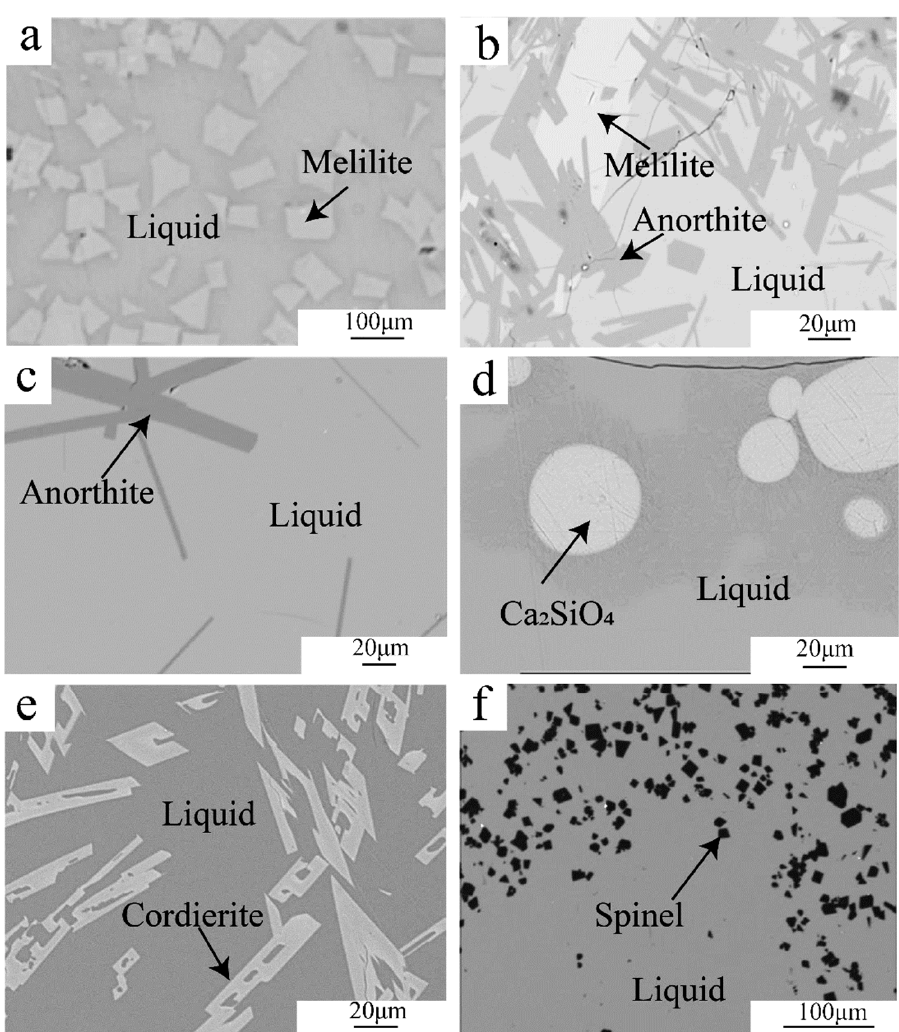
Figure 2. Typical microstructures of the quenched samples showing the equilibrium of liquid with solid phases [22]. ( a ) melilite, ( b ) melilite and anorthite, ( c ) anorthite, ( d ) Ca 2 SiO 4 , ( e ) cordierite and ( f ) spinel.